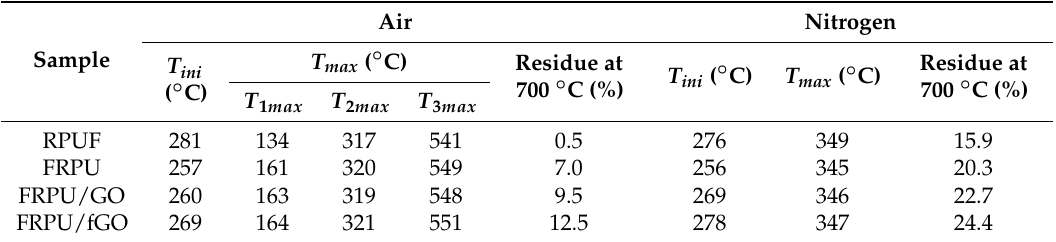
Figure 1. TG and DTG curves of the specimens under nitrogen and air atmospheres: ( a ) rigid polyurethane foam (RPUF); ( b ) flame-retardant-polyurethane systems (FRPU); ( c ) FRPU/ graphene oxide (GO); and ( d ) FRPU/ functionalized graphene oxide (fGO). Table 2. Typical thermogravimetric analysis (TG) parameters of flame retardant